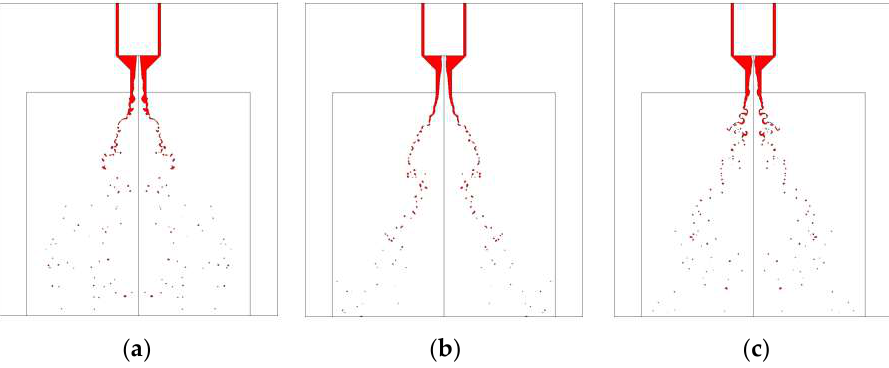
Figure 8. Comparison of MMH spray development at 5 ms under different switch speeds: ( a ) 0.125 m/s, ( b ) 0.25 m/s, ( c ) 1 m/s, with downstream orifice plate and 0.15 mm stroke.